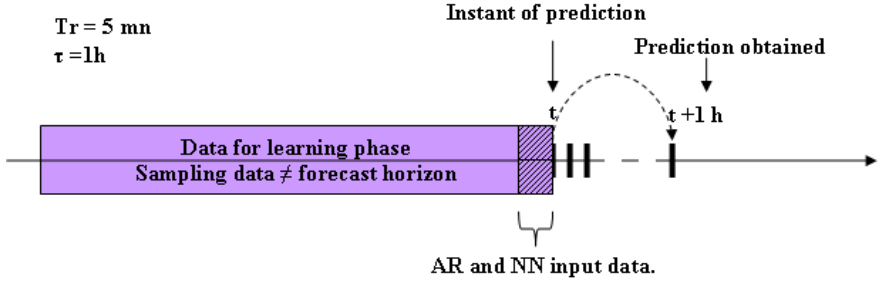
Figure 3. AR and NN flowchart used in Strategy 2 predicting directly the considered forecast